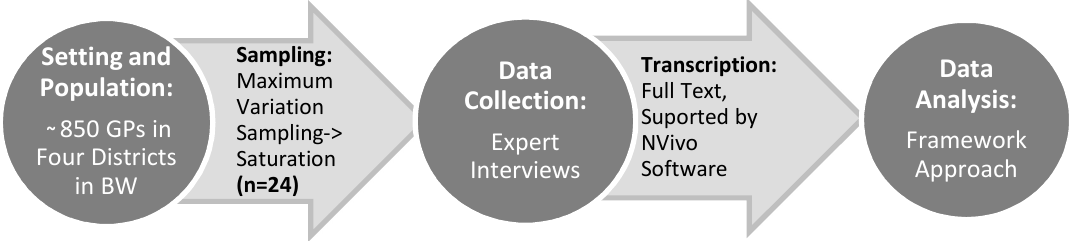
Figure 1. Overview of the study design. The Setting BW stands for Baden-Württemberg. Expert interview were conducted according to the method of Meuser and Nagel [46] and the framework approach for the data analysis followed the methodology of Ritchie and Spencer [47].